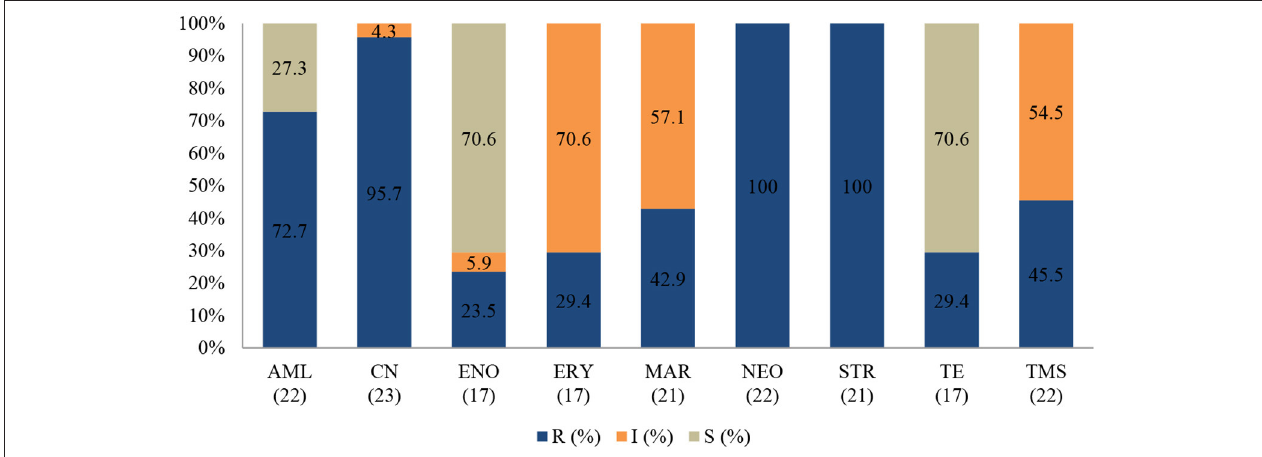
FIGURE 8 | Antibiotic susceptibility pattern of Enterococcus faecalis isolates from diseased non-ruminants (January 2015-December 2017). R-resistance; I-intermediate; S-susceptible; AML-amoxicillin; CN-gentamicin; ENO-enrofloxacin; ERY-erythromycin; MAR-marbofloxacin; NEO-neomycin; STR-streptomycin; TE-tetracycline; TMS-trimethoprim/sulfamethoxazole; Numbers inside brackets “()” indicate total number of tested isolates for each antibiotic.